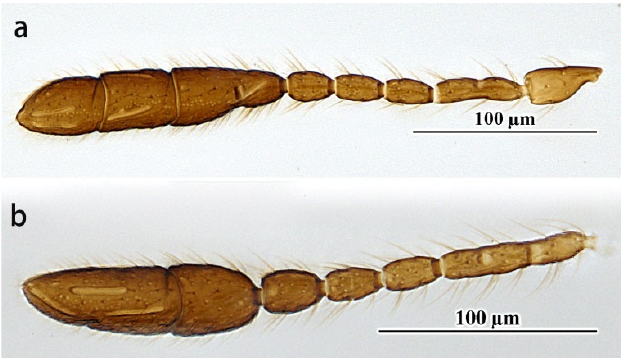
Figure 4. Pseudanaphes zhaoi . Female. ( a ), ( b ) Antenna (without scape and